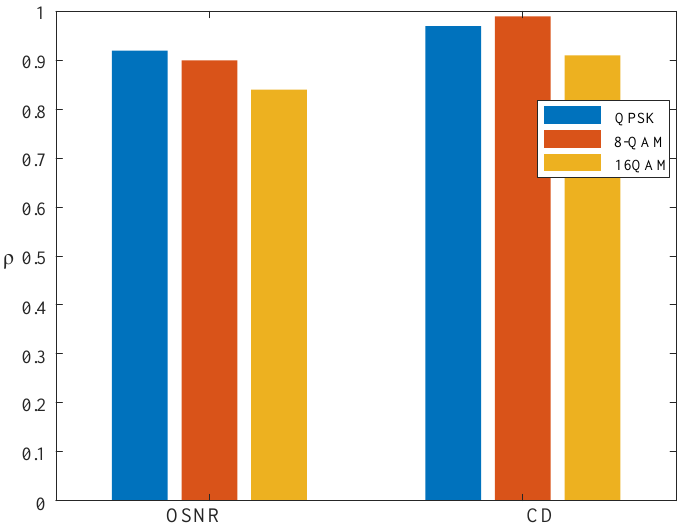
Figure 14. OPM results using V-DCT features and different modulation